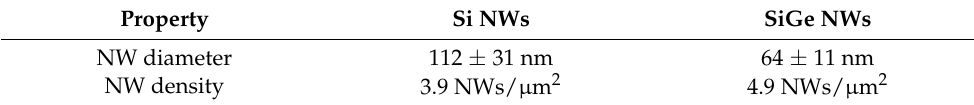
Table 2. Resulting properties of Si and SiGe NWs after their VLS-CVD